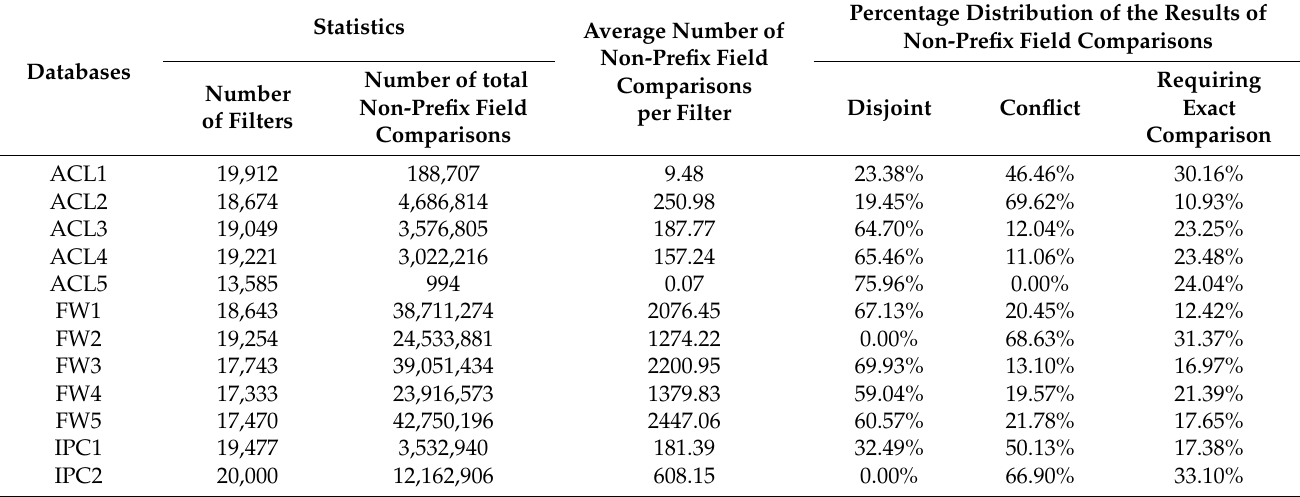
Table 11. Performance evaluation for 20 K filter